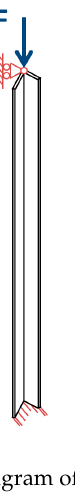
Figure 4. Material characteristic for the different models, alongside the engineering curve from the tensile test. •